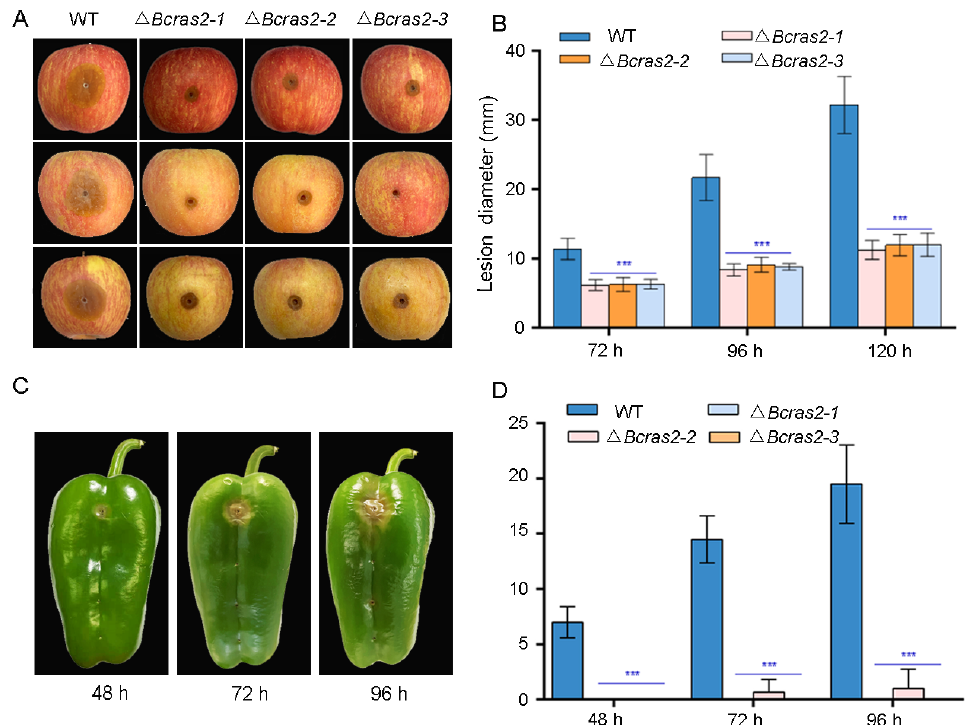
Figure 4. Virulence assays of Δ Bcras2 mutants and the wild-type on apples and green peppers. ( A ) Disease symptoms of Δ Bcras2 mutants and the wild-type on apple fruit. Images were captured 96 h post-inoculation. ( B ) Statistical analysis of Δ Bcras2 mutants and the wild-type on apple fruit. *** indicate significant differences ( p < 0.001). ( C ) Disease symptoms of Δ Bcras2 mutants and the wild-type on green peppers. Images were captured 48 h, 72 h, and 96 h post-inoculation. ( D ) Statistical analysis of Δ Bcras2 mutants and the wild-type on green peppers. *** indicate significant differences ( p < 0.001).